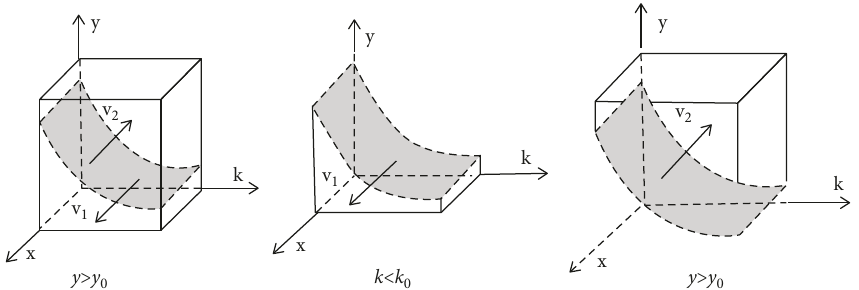
Figure 1: Replication dynamic phase diagram of